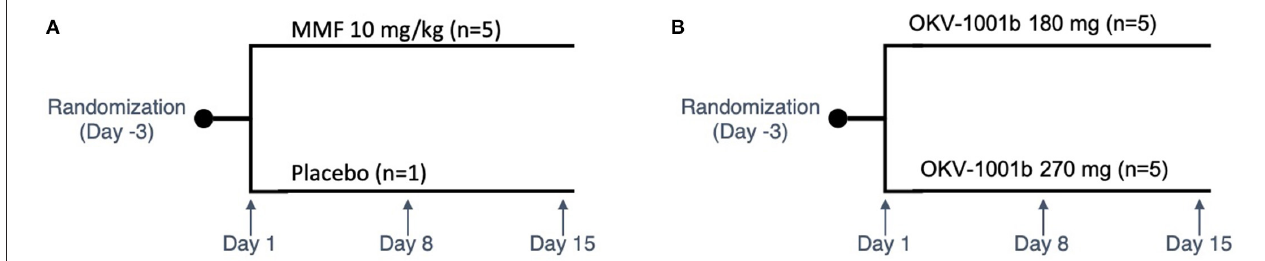
FIGURE 1 | Study design schema. Study 1 is shown in (A) . In Study 2 (B) , two groups of dogs were orally administered OKV-1001b once-daily for a 15-day period. PK and PD samples were collected on Days 1, 8, and 15. On each of these days, samples were collected at pre-dose, and at 2.5, 4, and 8h post-dose. On Day 8, additional PK samples were collected at 1, 2, and 6h